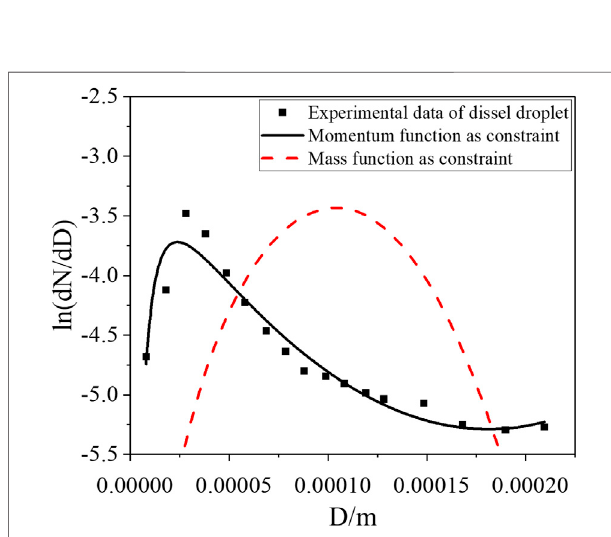
FIGURE 7 | Results of JNC sodium droplet size distribution under the pressure difference of 0.2